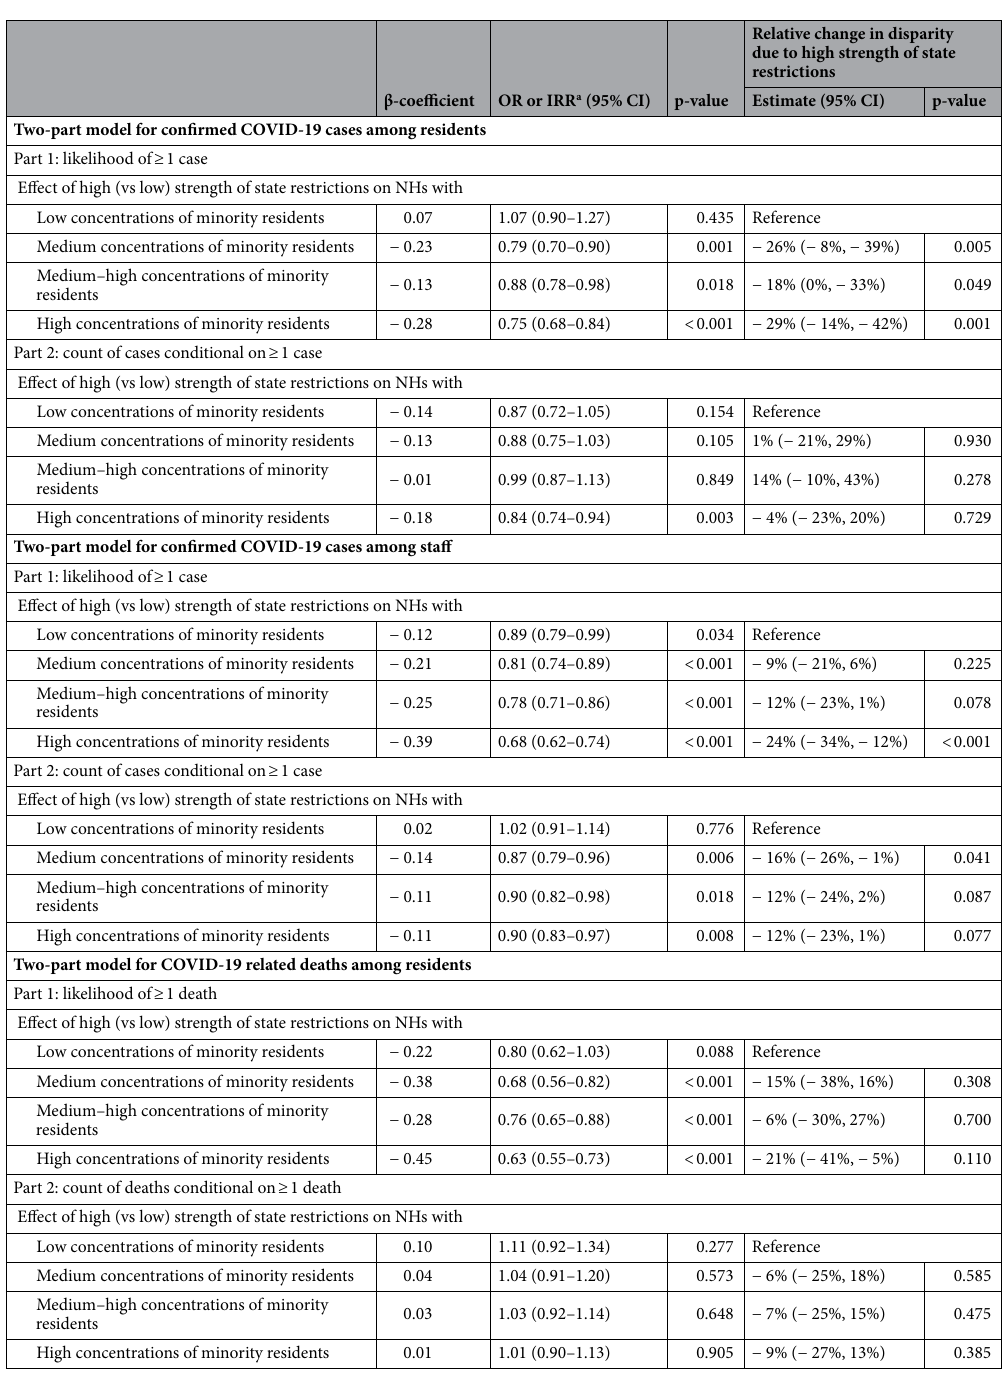
Table 3. Associations between the strength of state social distancing measures and disparities in COVID-19 outcomes across nursing homes (NHs) serving different proportions of racial/ethnic minority residents. Based on two-part models for confirmed cases and deaths separately that adjusted for nursing home, county, and state covariates, time trend, and the clustering of repeated observations of nursing homes. OR odds ratio, IRR incidence rate ratio, 95% CI 95% confidence interval. a ORs are reported for part 1 of the two-part models and IRR are reported for part 2 of the two-part